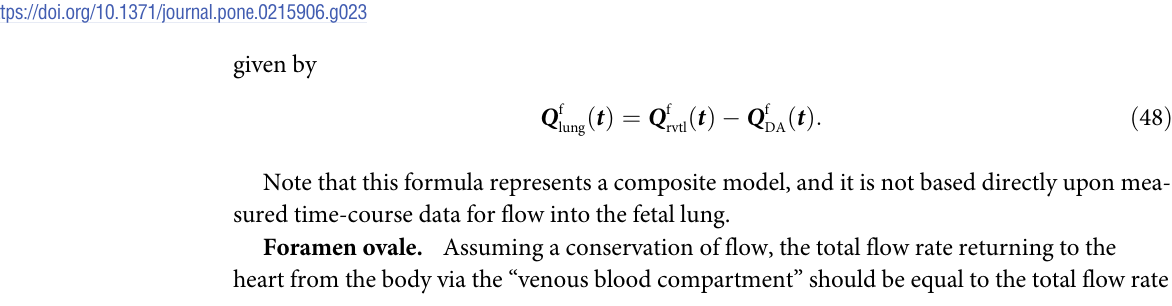
Table 26. Fetal ductus arteriosus blood flow models (mL/min vs. fetal mass in g for power law models, mL/min vs. gestational age in weeks for all other models).